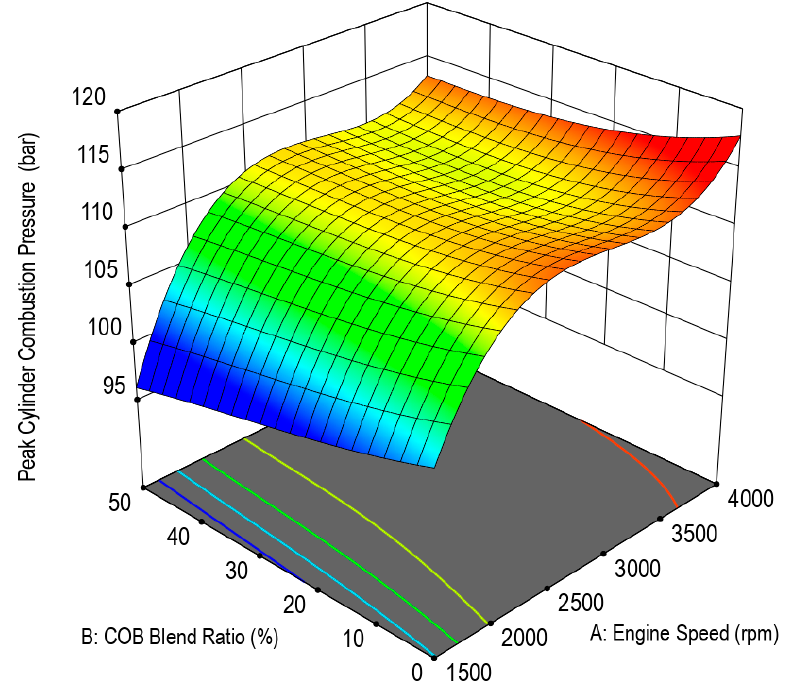
Figure 2. Peak cylinder pressure for various types of biodiesel–diesel blend fuels at different engine speeds.